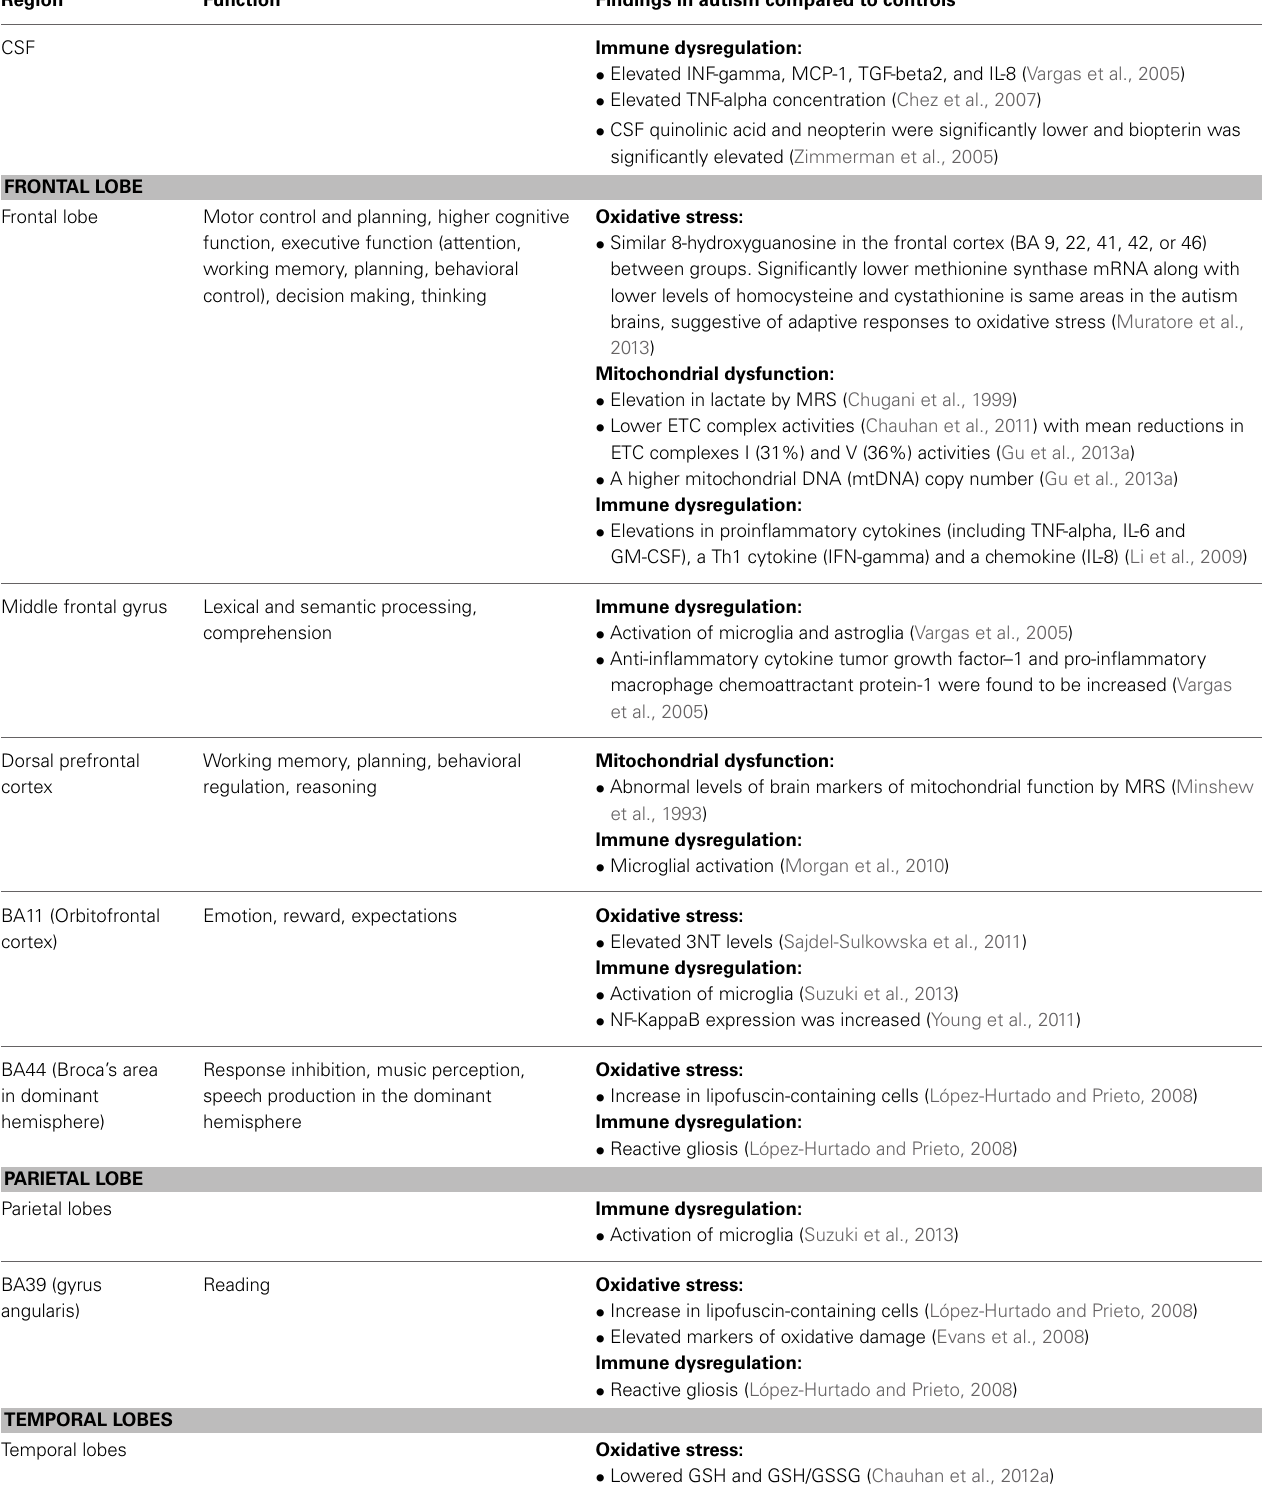
Table 4 | Regions affected along with function/findings; organized by oxidative stress, mitochondrial dysfunction and immune dysregulation.